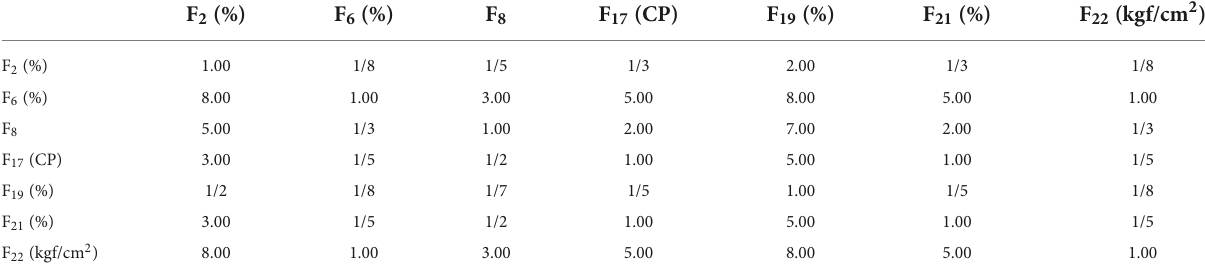
TABLE 8 Judgment matrix.